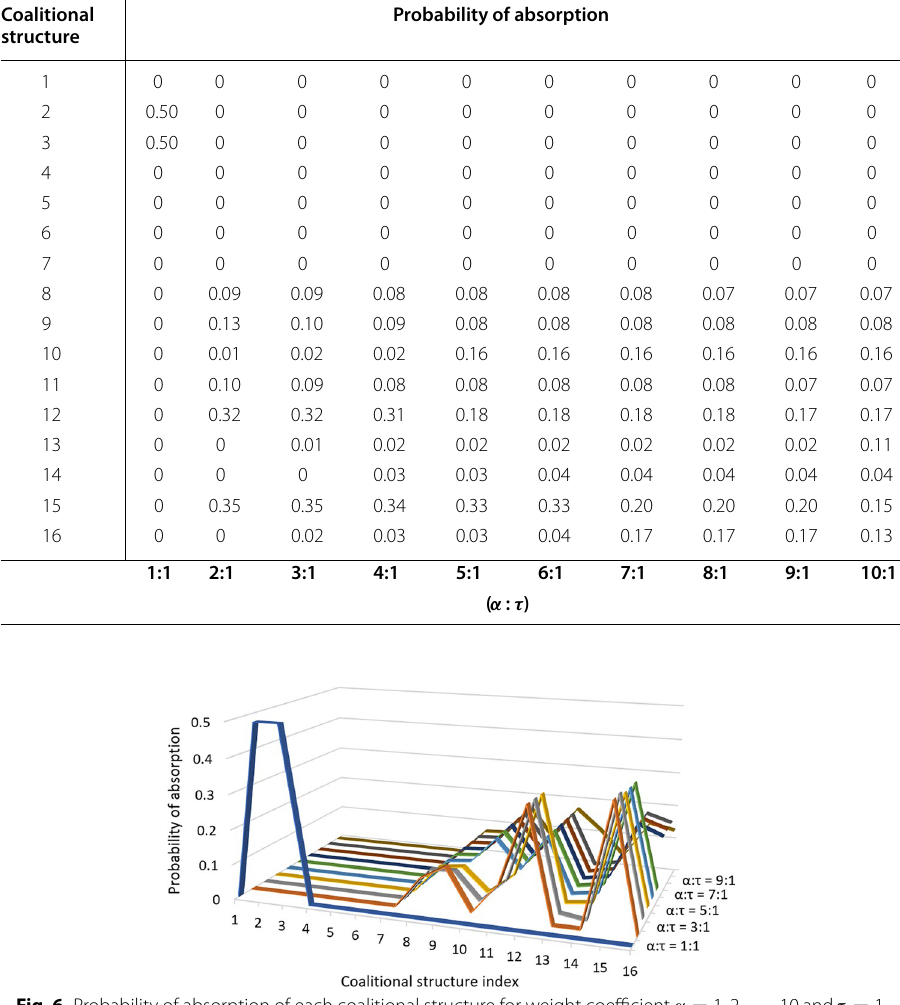
Probability of absorption